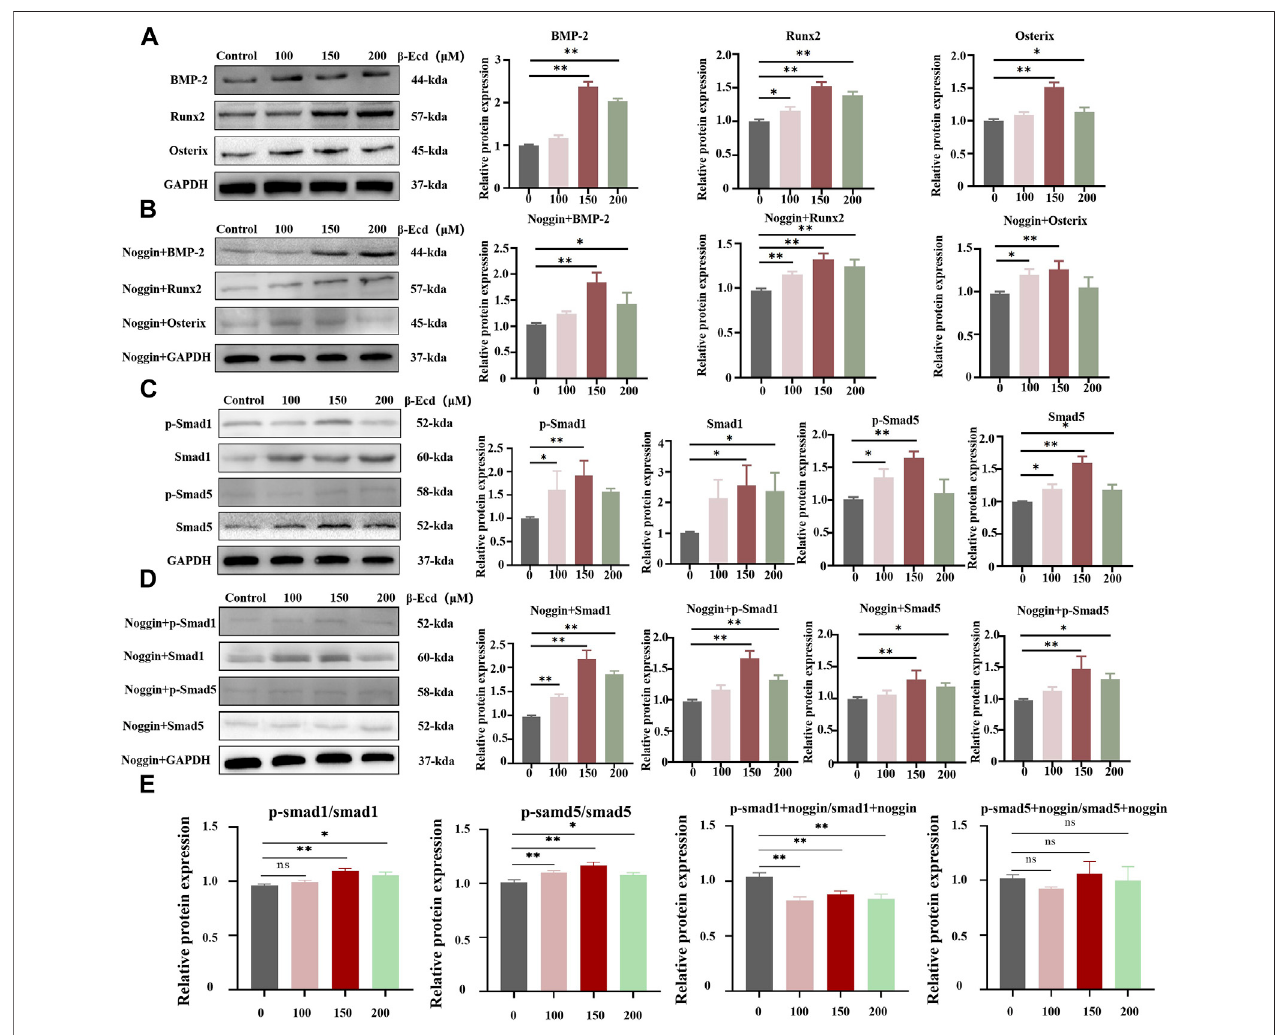
FIGURE 4 | Western blotting detection of BMP-2, Smad1/5, p-Smad1/5, Runx2 and Osterix protein expression levels in MC3TE-E1 cultured with β -Ecd and noggin. (A,B) , BMP-2, Runx2, Osterix protein expression levels, (C,D) , Smad1/5, phosphorylated (p)-Smad1/5 protein expression levels. (E) the ratio of the protein to phos-protein, β -Ecdcouldincreasedtheratiooftheproteintophos-protein,but,thenoggininhibitthis.ImageJsoftwarewasusedtocalculatethedensitometricanalysis of the protein bands ( N = 3; *p < 0.05, **p < 0.001).